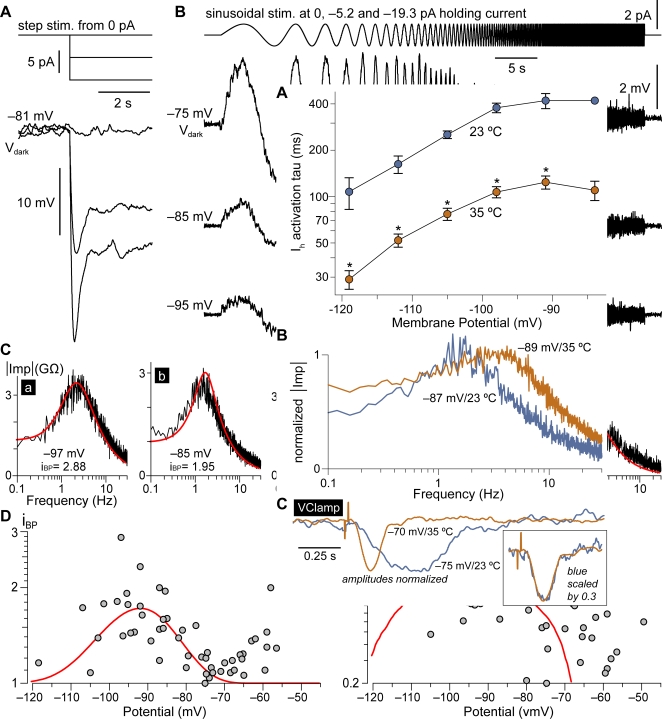
RBCs display band–pass behavior in current–clamp.Ih, in its range of activation, fully accounts for it. A, RBC subjected to negative current steps from rest displayed voltage overshoots at step onset—a classical hallmark of Ih. B, The frequency response of another RBC was explored with sinusoidal current stimuli of constant amplitude but modulated in frequency (0.1 to 30 Hz; top trace). When the stimulus was delivered at −75 mV the amplitude of the cell's voltage response decreased progressively with increasing frequency. At two more hyperpolarized potentials, on the other hand, the peak response occurred in the middle of the stimulus, at an intermediate frequency. Traces are averages of 6–9 sweeps. C, Graphs show, as a function of frequency, the modulus of input impedance computed from sinusoidal stimulus–response pairs (noisy black traces; see Materials and Methods). A selection from several RBCs, and covering a range of potentials, is presented in a–e. Band–pass behavior is clear–cut in a–c and in e. The membrane potential and a band–pass index iBP (see Results) are given for each graph. Band–pass impedance profiles at −82 mV and more negative (a–c) are predicted by a simplified theoretical model of each RBC, which includes passive properties and Ih as the only active current (see Results). Theoretical impedance profiles (red traces) were derived by linearizing the model (see Materials and Methods) and thus apply to small input signals. D, Summary of data from all RBCs in the form of iBP versus tested potential (circles). Band–pass behavior is expressed <−75 mV and >−70 mV. The average iBP predicted by all RBC theoretical models (red curve) shows that, negative to −75 mV, the observed frequency tuning is fully explained by Ih, while above −70 mV some other current must come into play. E, Summary of resonant (peak response) frequency data from all RBCs (circles). The models correctly predict, in a wide potential range centered around Ih half–activation, an average value of about 1 Hz (red curve).